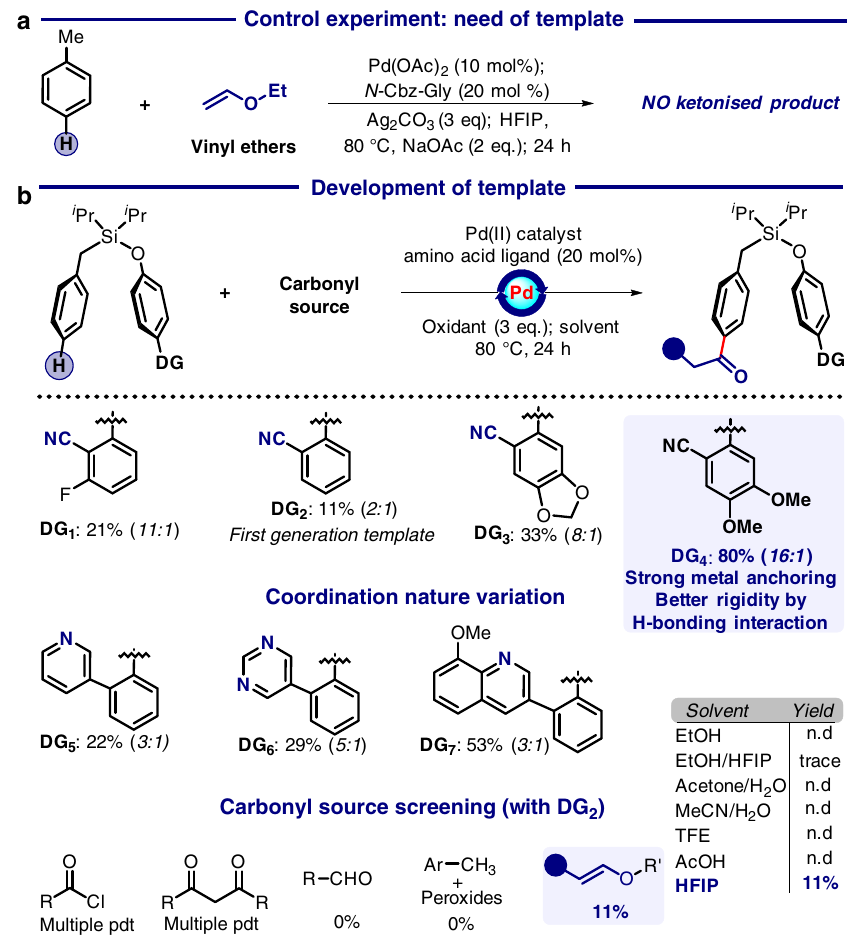
Fig. 2 Development of para -ketonisation reaction. a Signi fi cance of the directing group. b Screening of the reaction